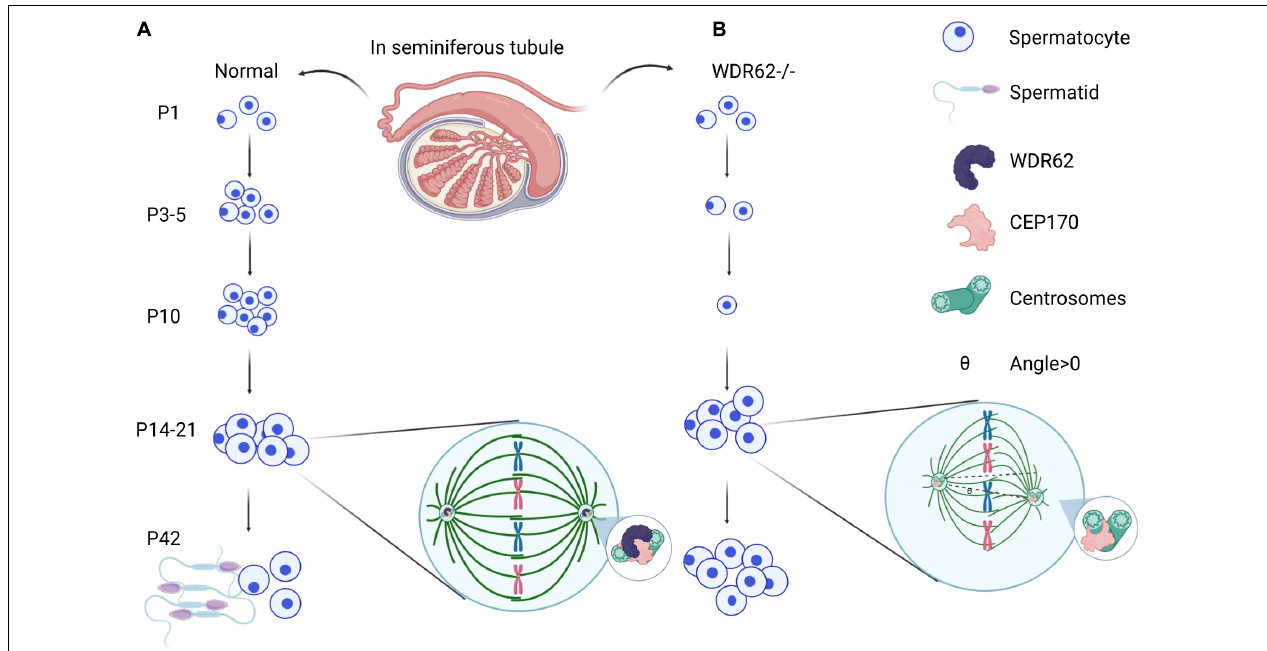
FIGURE 3 | WDR62 in spermatogenesis. (A) Male meiosis begins with a cell called a primary spermatocyte. Spermatids are the products of meiosis from the tetraploid primary spermatocytes via meiotic cell division. (B) WDR62 deficiency resulted in a loss of germ cells at P3, P5 and P10, which was gradually recovered from at P14-P21. During meiosis, the spindle of spermatocytes from Wdr62 KO mice is disrupted, and the position of the spindle poles is asymmetric. The intensity of α -tubulin is markedly diminished in WDR62 deficient spermatocytes, and the angle of intersection between the polar axis of the main axis and the plane direction ( θ ) is markedly increased, leading to meiotic arrest. P, postnatal